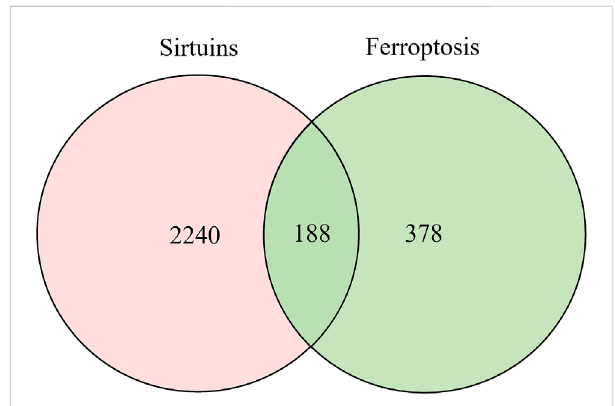
FIGURE 3 Venn diagram of downstream regulatory genes in sirtuins and ferroptosis: After screening the sirtuins family-related genes and ferroptosis-related genes from the Genecards and Ferrdb databases, respectively, a Venn diagram of the genes linked to the seven membersofthesirtuinsfamilyandthegenesrelatedtoferroptosiswas constructed in the Evenn